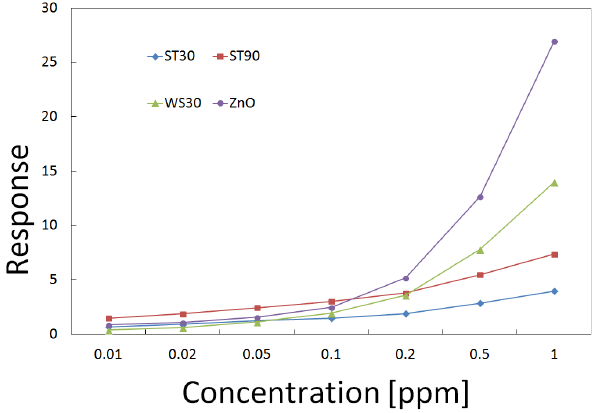
Responses vs. ethyl mercaptan from 0.01 to 1ppm dis- persed in a dry carrier.